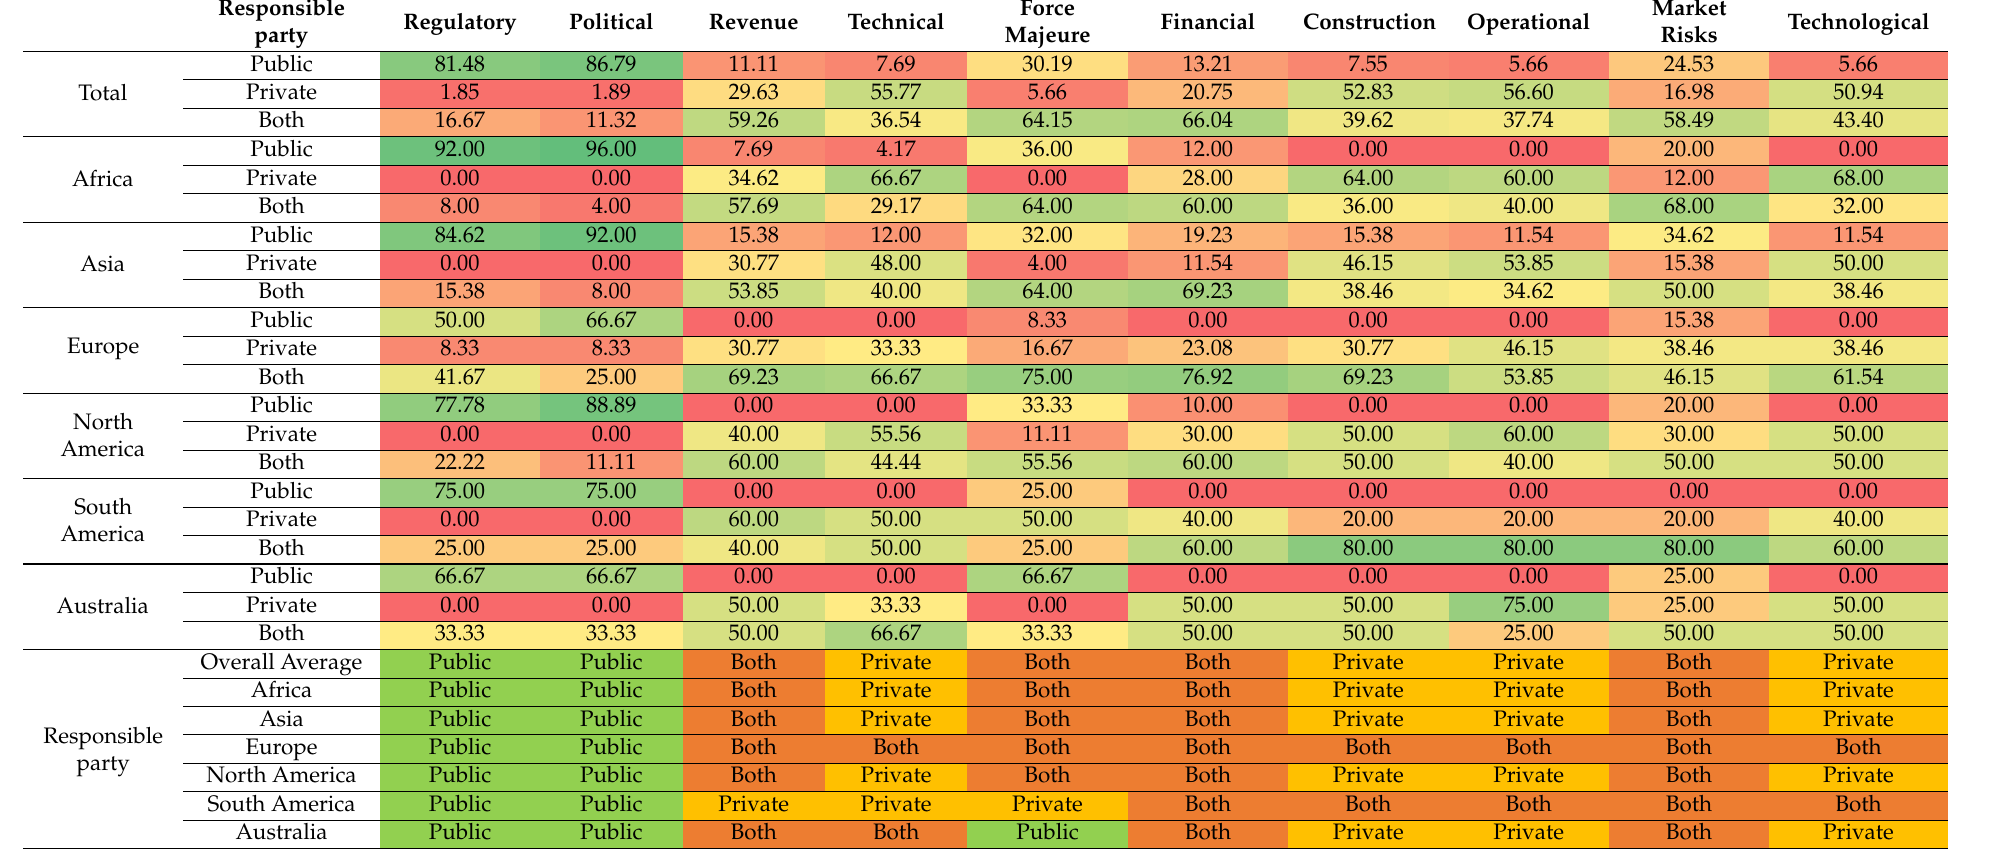
Table 5. Percentage of respondents assigning every barrier to the public sector, private sector, or both across the six continents. Regulatory Political Revenue Technical